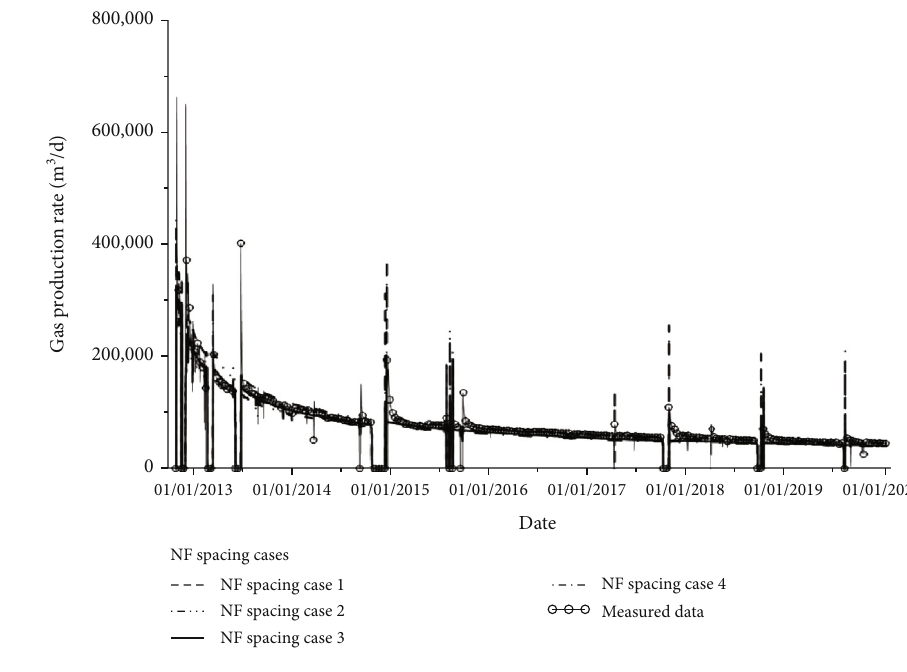
Figure 13: Reservoir simulation results of di ff erent NF